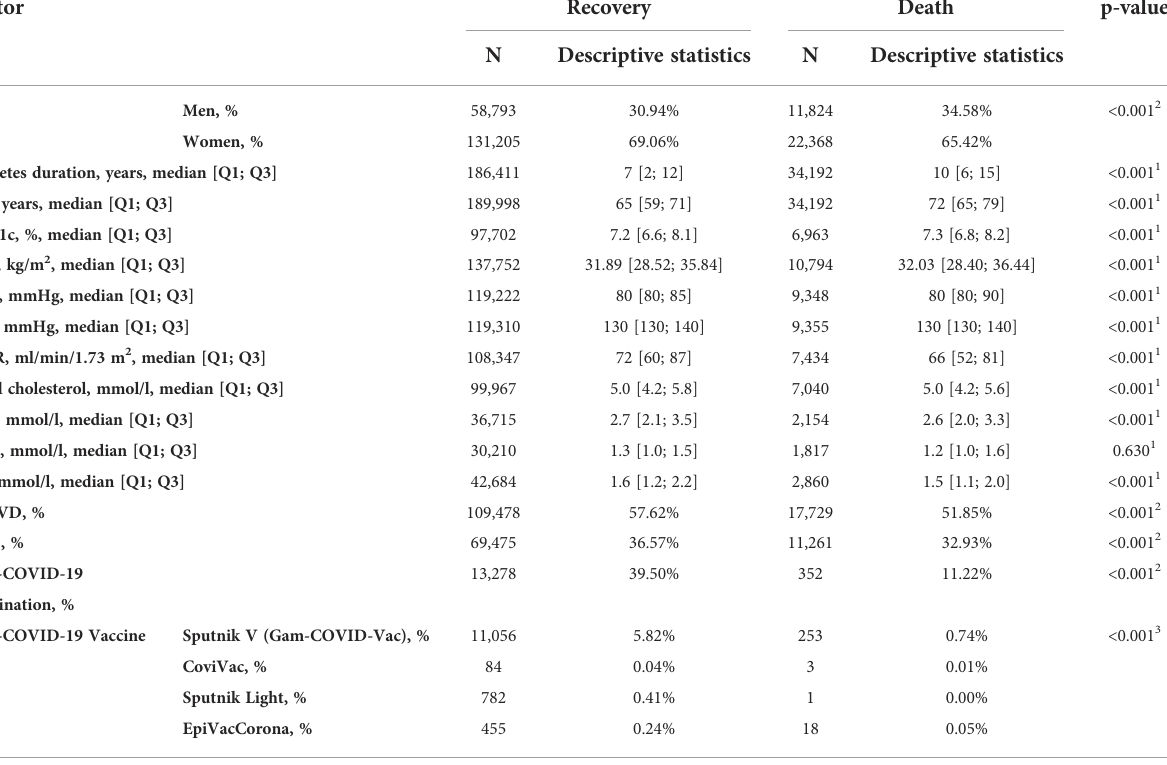
TABLE 2 Clinical characteristics of T2DM patients according to the clinical outcome (n = 224,190).